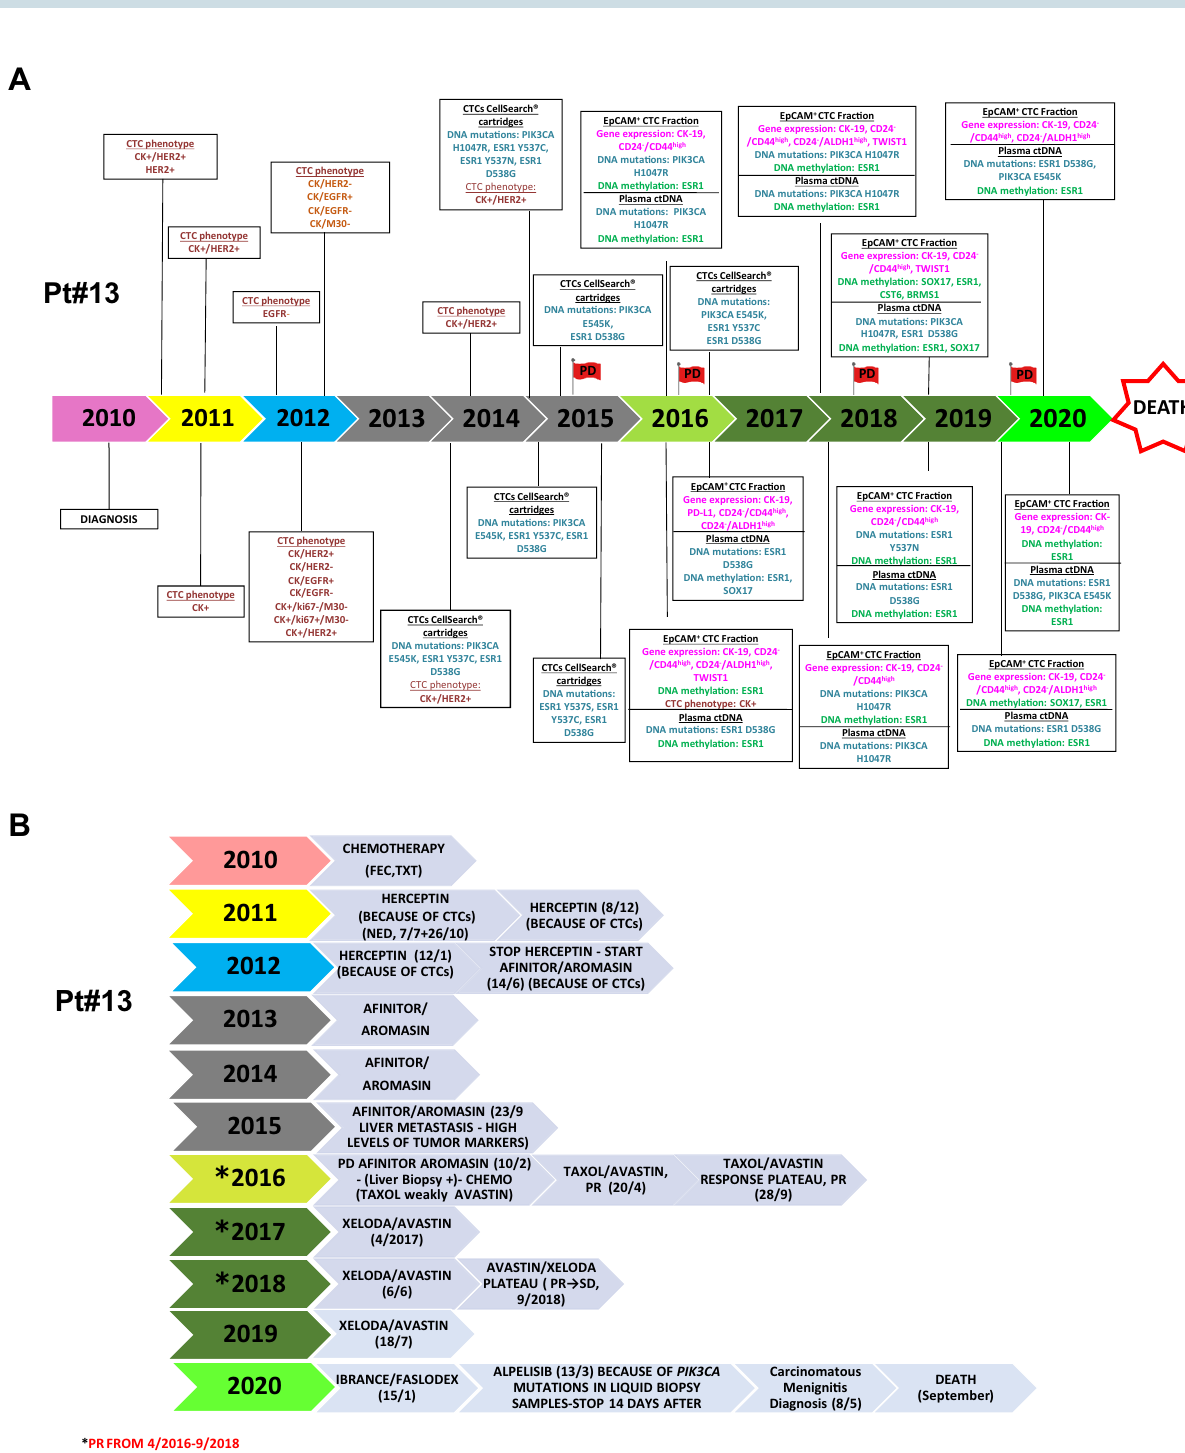
Figure 3. P#13: ( A ) timeline of disease course from diagnosis onward including info on the various treatments, and the phenotypic characterization of CTCs based on IF. The red flags represent onset of relapses. ( B ) Timeline of